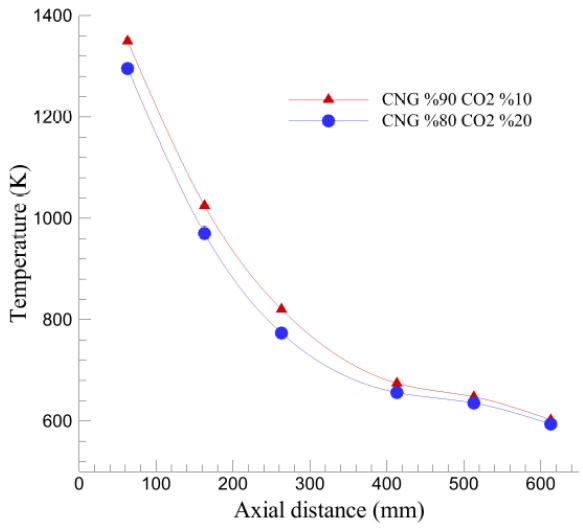
Figure 5: Axial temperature distributions (Swirl number: 0.4, Equiva- lence ratio: 0.9).